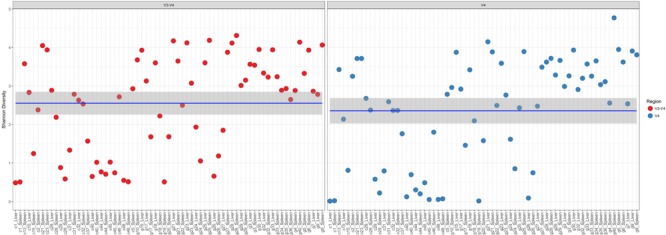
Shannon diversity within the total microbiome data. Diversity estimates are colored (red dots, V3-4 regions and blue dots, V4 region) and faceted by 16S rRNA gene hypervariable region group. Mean values (and confidence intervals) in each group are also illustrated. The mean Shannon diversity for both groups is approximately 2.5.